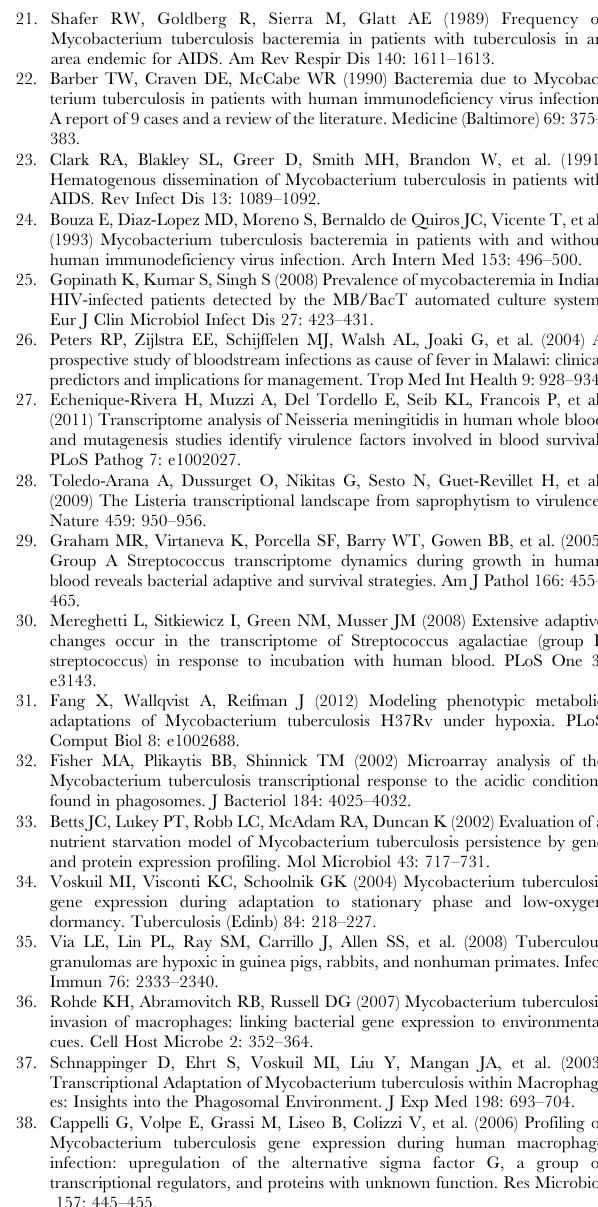
Table S3 M. tb genes differentially expressed in blood from HIV + patients. (PDF) Table S4 M. tb ESX loci-related genes and genes encoding ESAT-6-like proteins outside ESX loci upregu- lated in blood from HIV- and/or HIV + subjects. Table S5 Distribution of differentially expressed DevR (DosR)-regulon genes in blood from HIV- and/or HIV + subjects in this study and in two published intra- macrophage microarray studies. Table S6 Primers used for